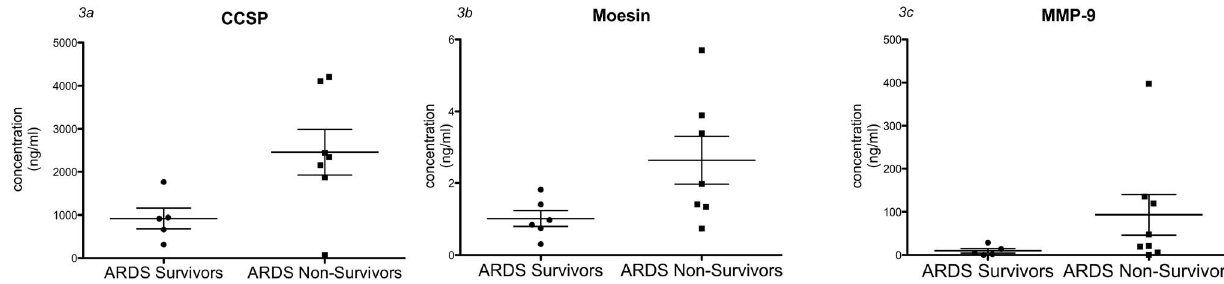
Figure 3. Protein levels of selected candidates. ELISA was performed to quantify CCSP, Moesin and MMP9. Levels of these proteins were higher in early phase non-survivors in comparison to survivor (p-value , 0.05 t-test) for CCSP and , 0.1 for Moesin.